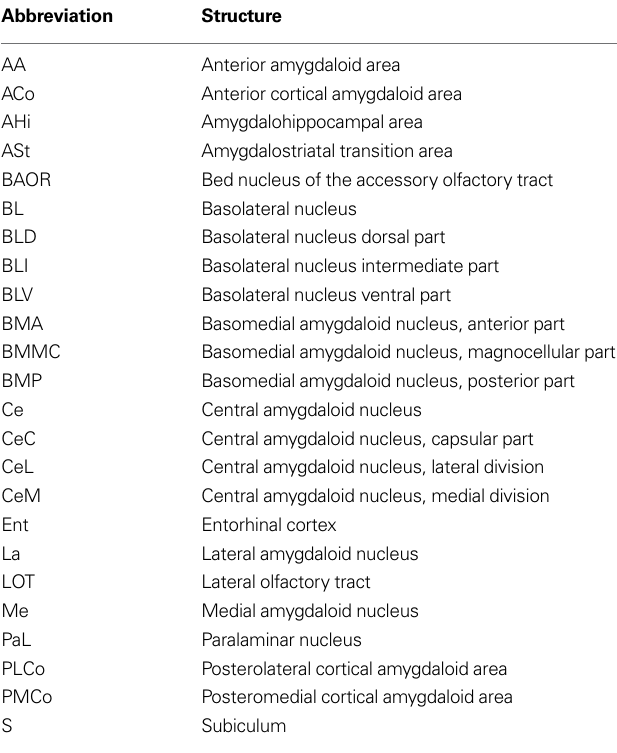
Table 1 | List of abbreviations used to structures identifi ed in the fi gures and